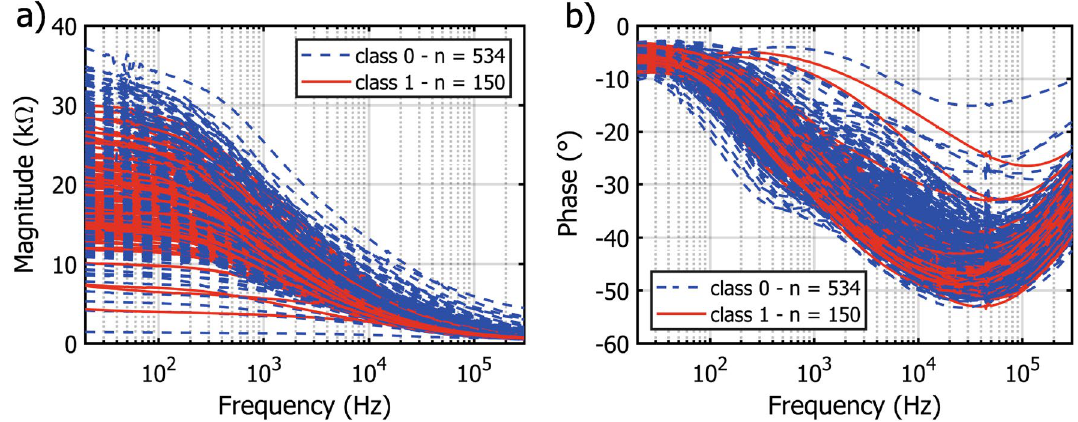
Figure 4. Overview of the training set of bioimpedance magnitude ( a ) and phase ( b ) spectra for both classes of ripeness, ripe (class 1, red line) and unripe (class 0, blue